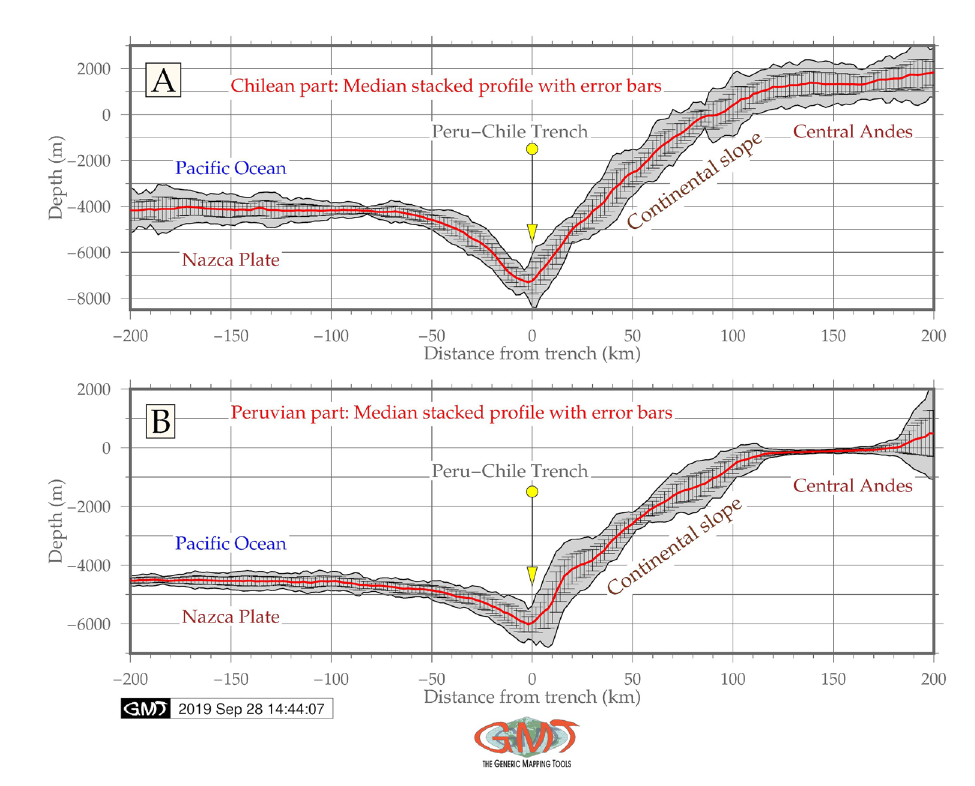
Fig. 6. Automatically digitized profiles: GMT-based